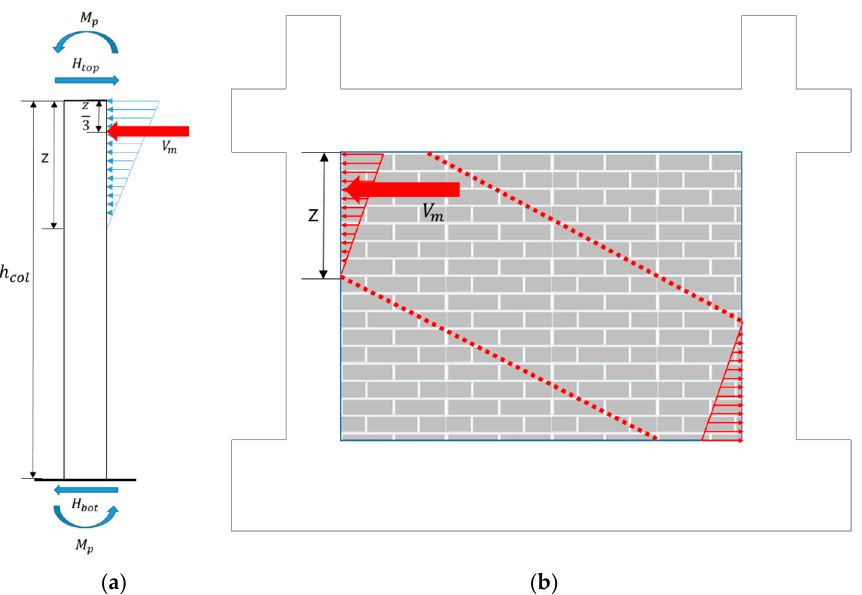
Figure 10. Free body diagram of the windward column subjected to reaction from masonry infill. ( a ) Free body diagram. ( b ) Horizontal component of strut force.